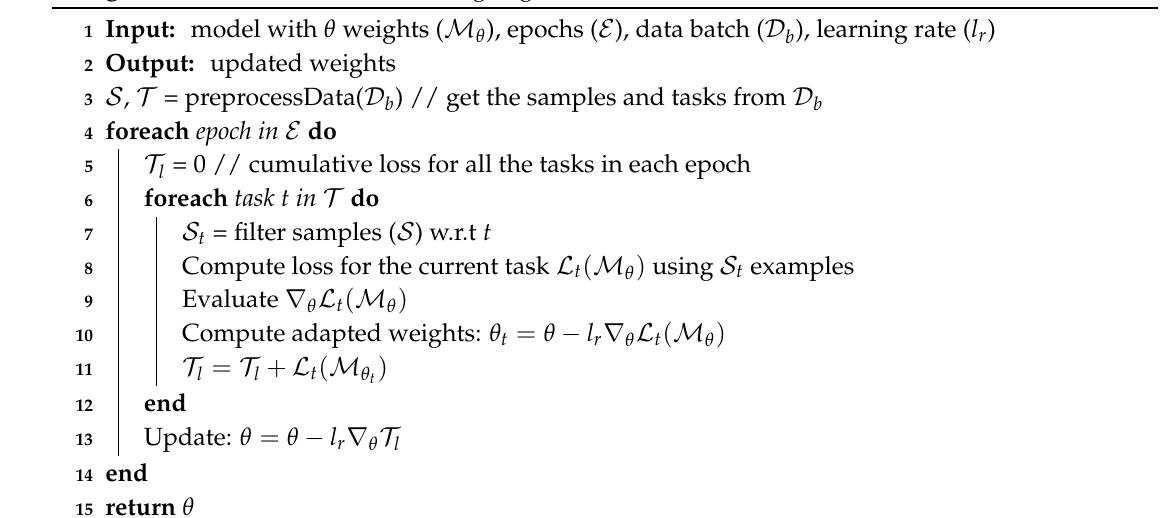
Algorithm 1: Meta Transfer Learning